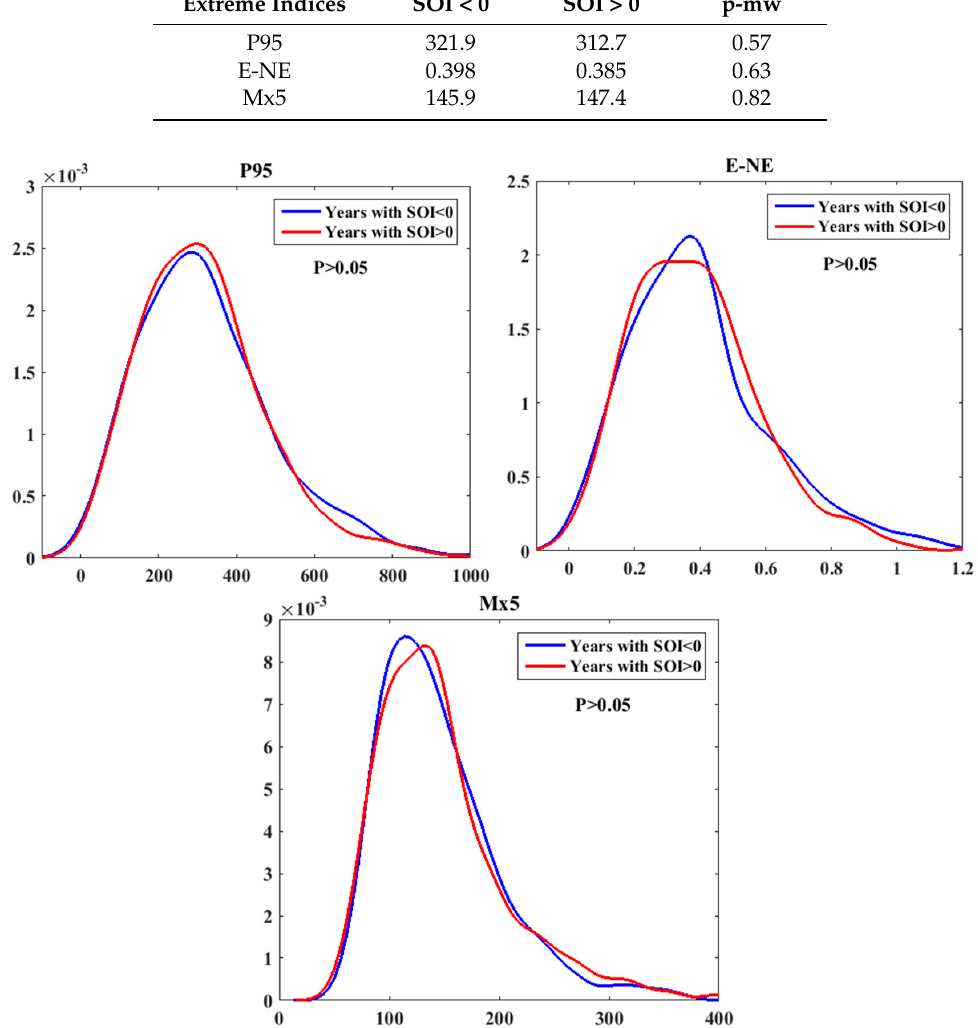
Figure 10. Density distributions for P95 , E-NE and Mx5 , respectively, for the class I years (blue) and class II years (red) periods. Statistical significance was estimated using the Kolmogorov–Smirnov test for distributions of the extreme precipitation indices.